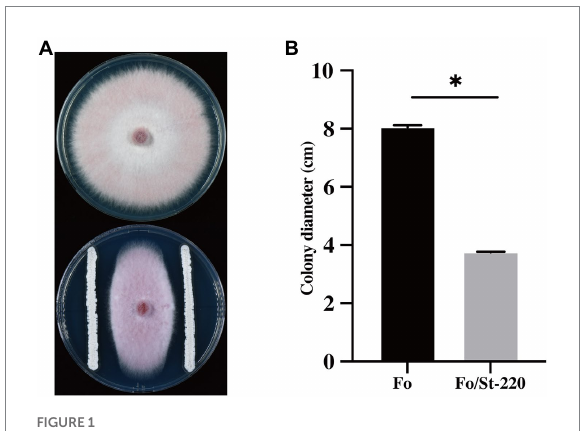
FIGURE 1 The antifungal activity of strain St-220 against Fusarium oxysporum . (A) F. oxysporum colony grew on PDA plate alone (upper) and with St-220 (lower) at 7 days after inoculation. (B) Colony diameter of F. oxysporum in each treatment. Bars with ∗ above are statistically different ( p <